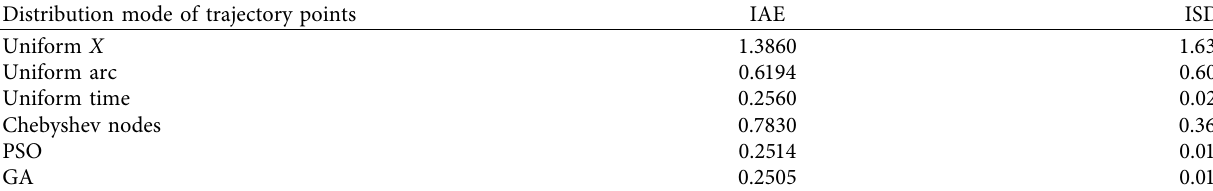
Table 9: Performance index values of multiple distribution